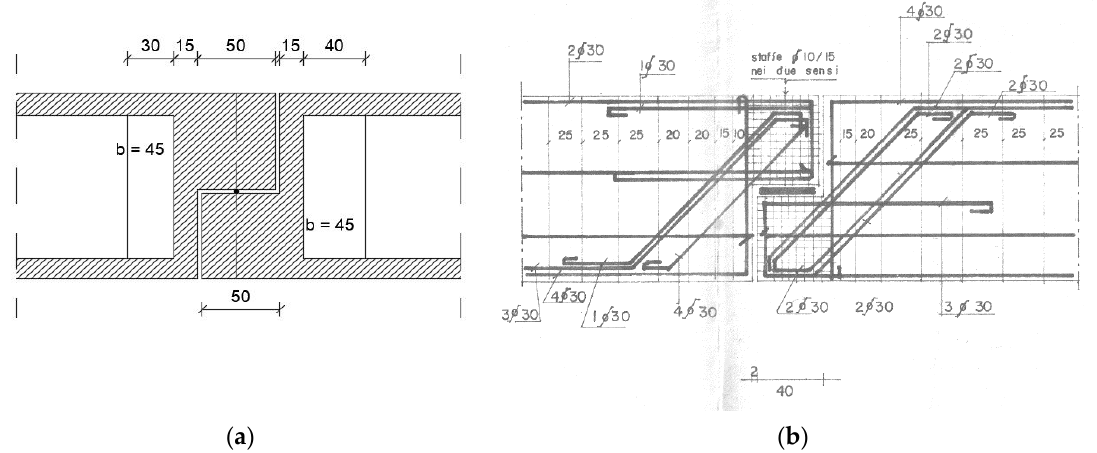
Figure 6. ( a ) Geometry and ( b ) structural details of Gerber saddles from the original design drawings by Sergio Musmeci (dimensions in cm).